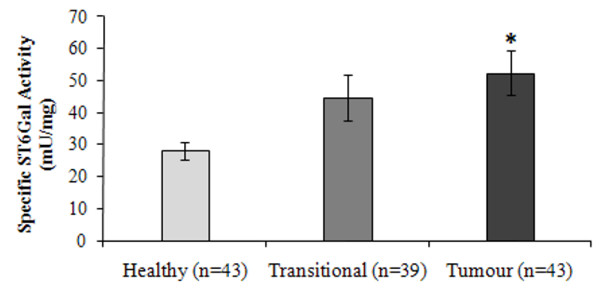
ST6Gal I activity in healthy, transitional and tumour tissues from the patients with CRC analyzed. Data are expressed as μU/mg protein and represent the means ± standard error of the means of the n independent determinations carried out per duplicate. *p < 0.05 between tumour and its relative healthy tissue according to the Wilcoxon's test.